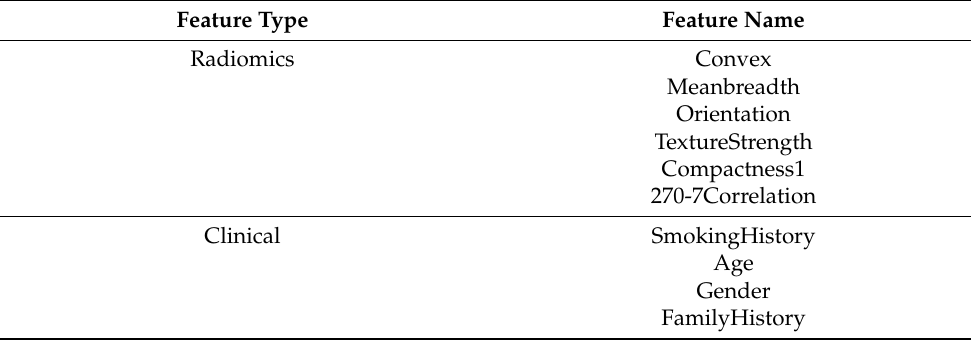
Table 6. A combined subset of features with radiomics and clinical.